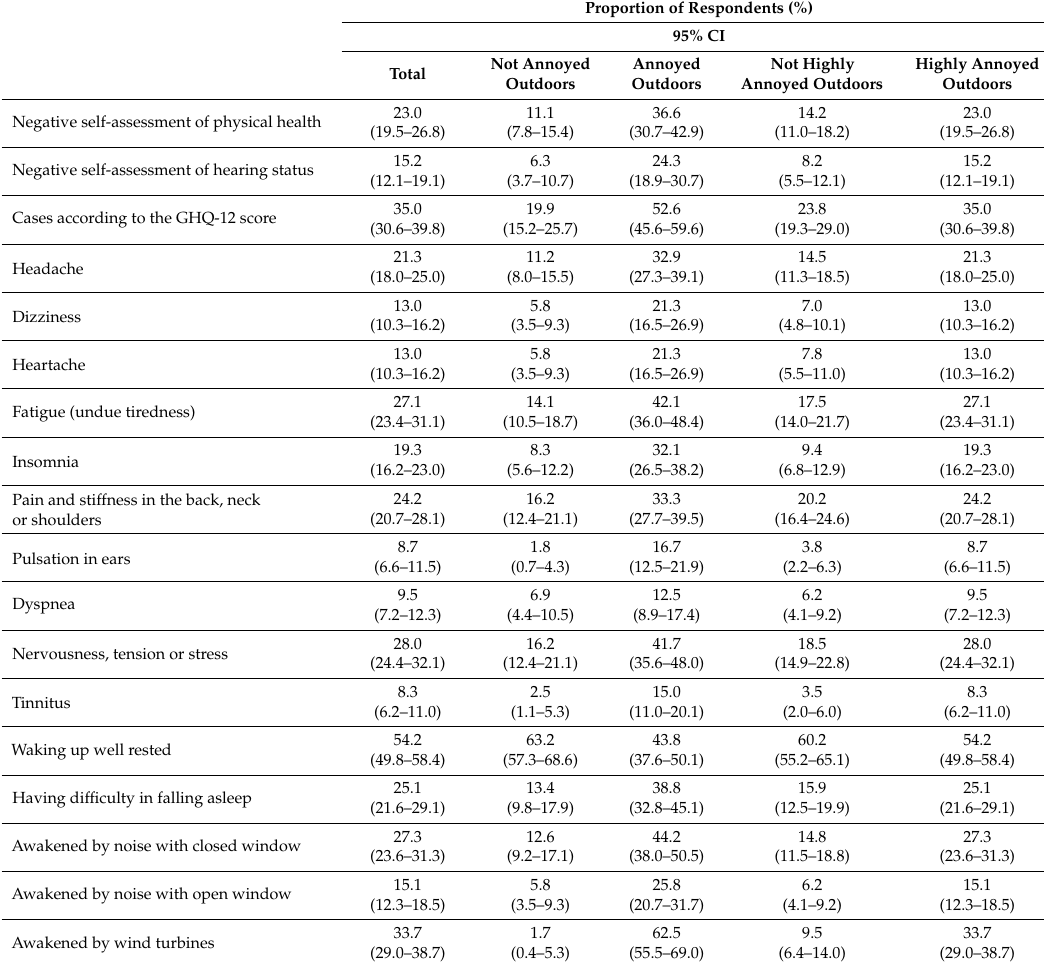
Table 7. Proportions of respondents (with 95% confidence intervals) who assessed their physical health negatively, being categorized as “cases” based on the GHQ-12 score, and frequently reported various complaints in total and in subgroups of subjects annoyed and not annoyed by the wind turbine noise 1